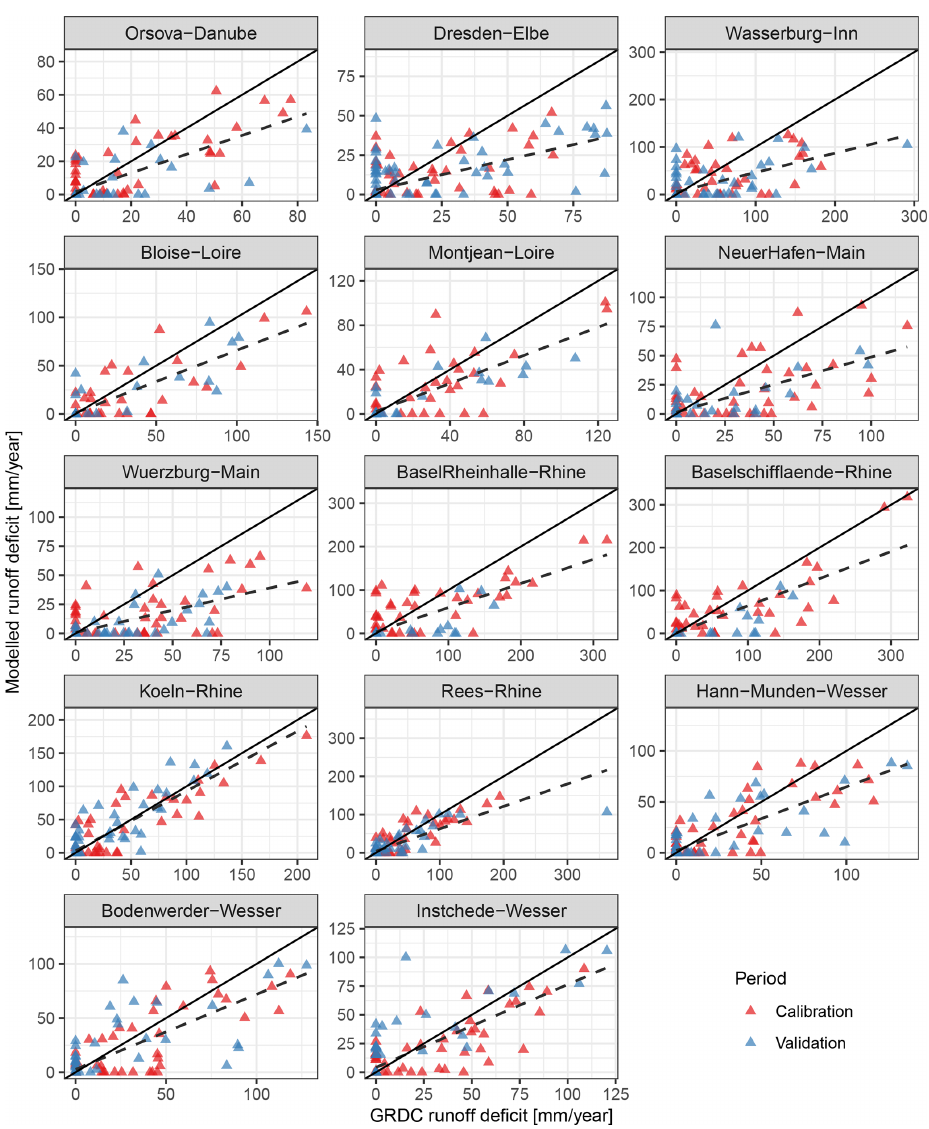
Figure 10. The observed and simulated runoff deficit based on the 33rd percentile threshold for 14 selected catchments during the calibration and validation period. The solid line represents the 1 : 1 relation, and the dashed line corresponds to fitted regression between observed and simulated runoff.